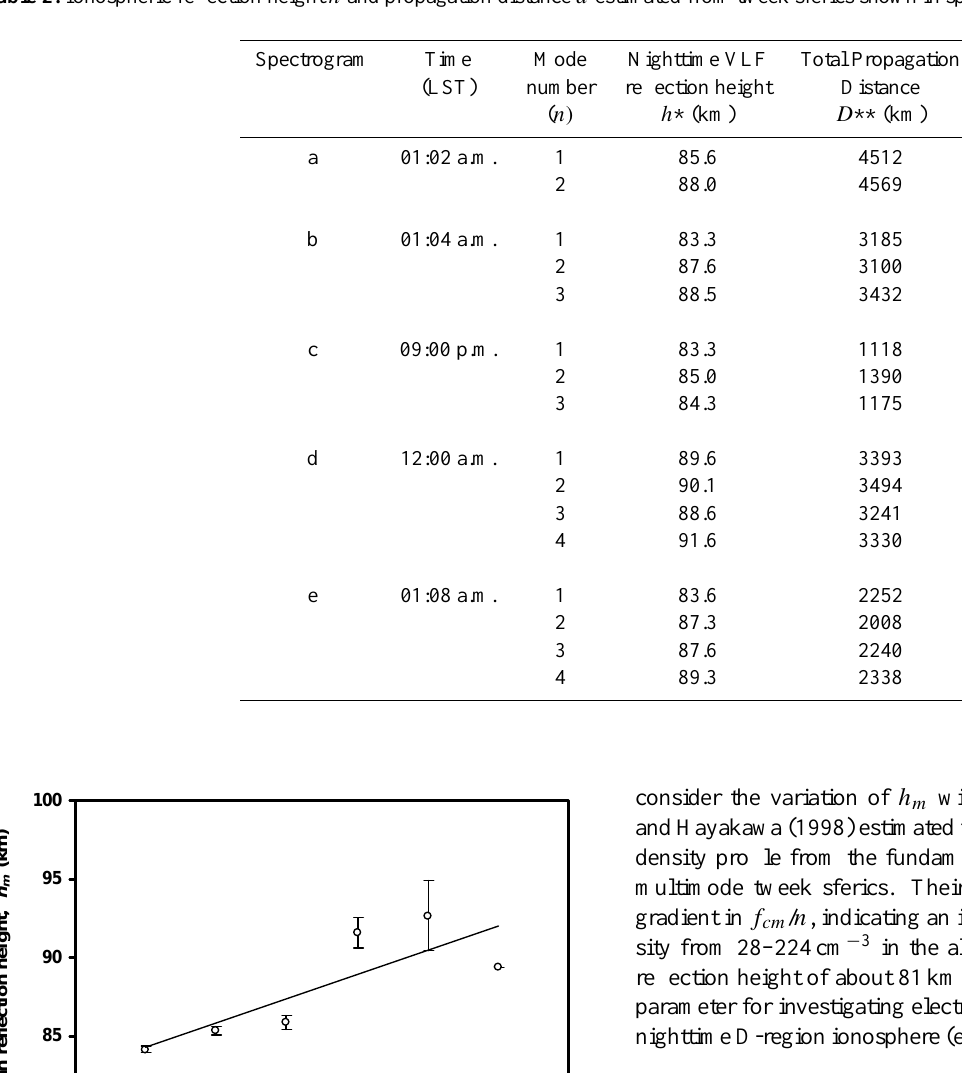
Table 2. Ionospheric reflection height h and propagation distance d estimated from tweek sferics shown in spectrograms (a–e) of Fig. 1.